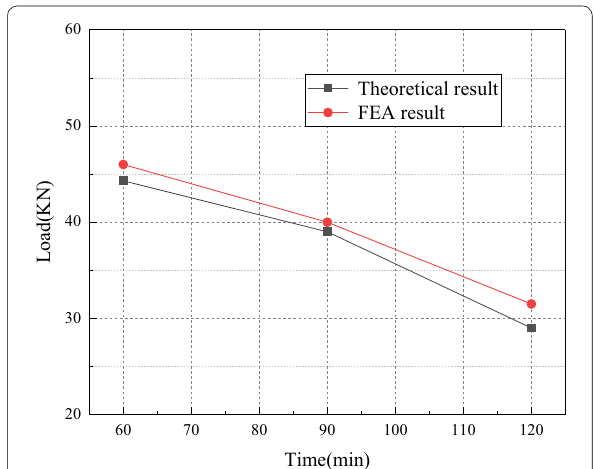
Fig. 20 Comparison of theoretical calculation and finite-element calculation